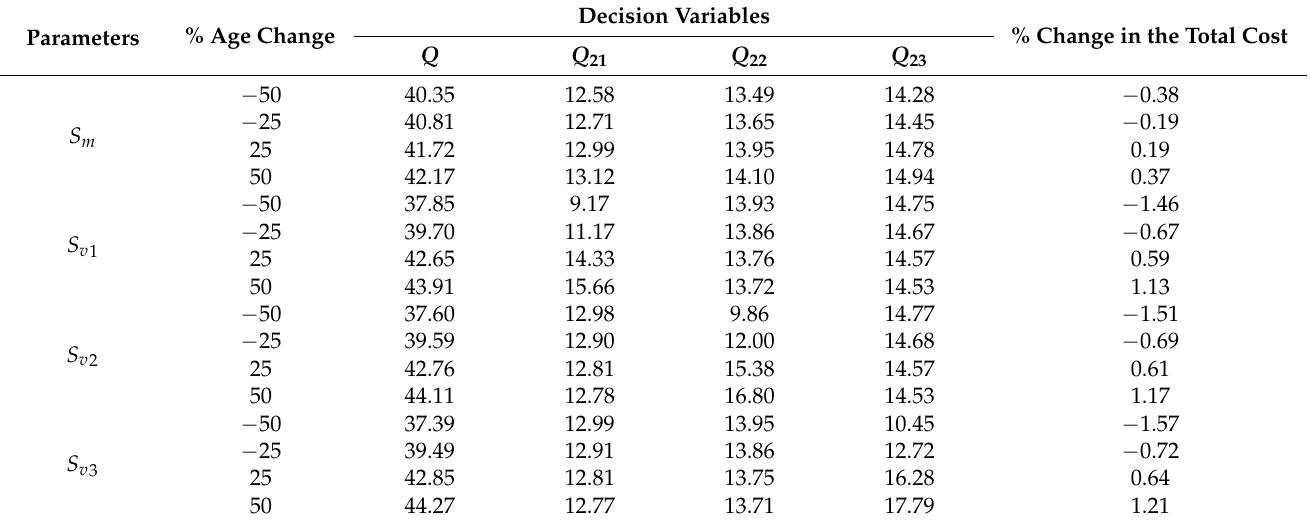
Table A1. Sensitivity analysis for setup cost of manufacturer and outsourcers.